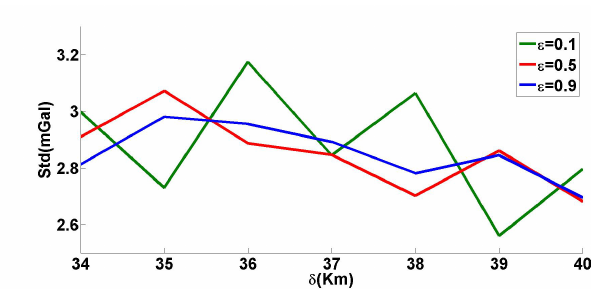
Fig. 8. Std of the differences between SMLS approximated values and those from shipborne gravimetry, as a function of δ , Gaussian weight function, ϵ = 0.1, 0.5,